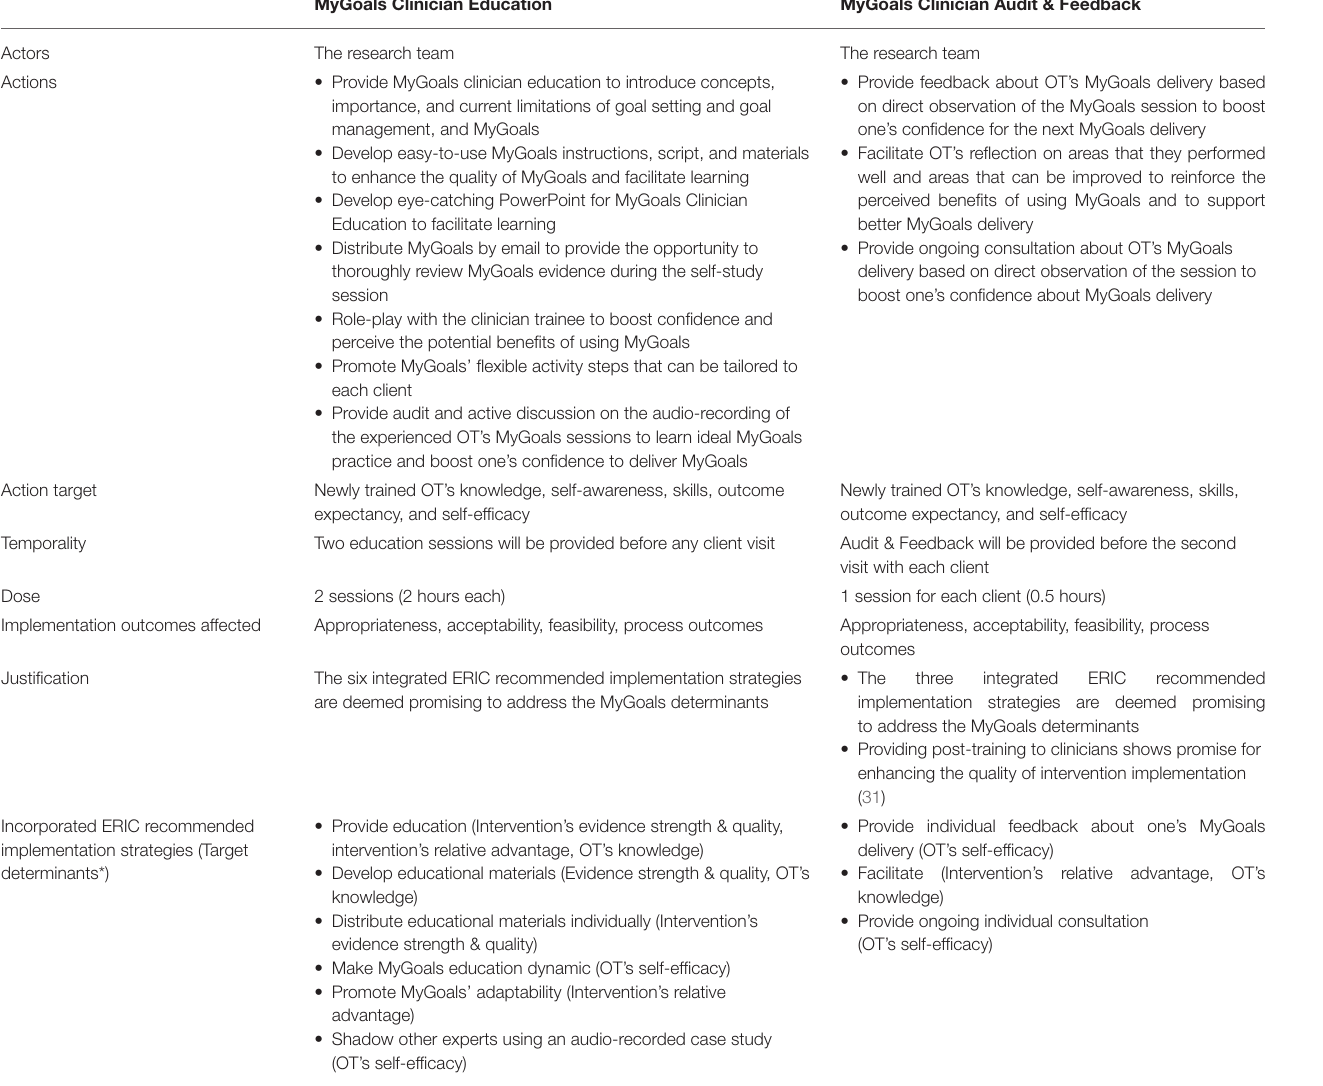
TABLE 2 | MyGoals implementation strategies